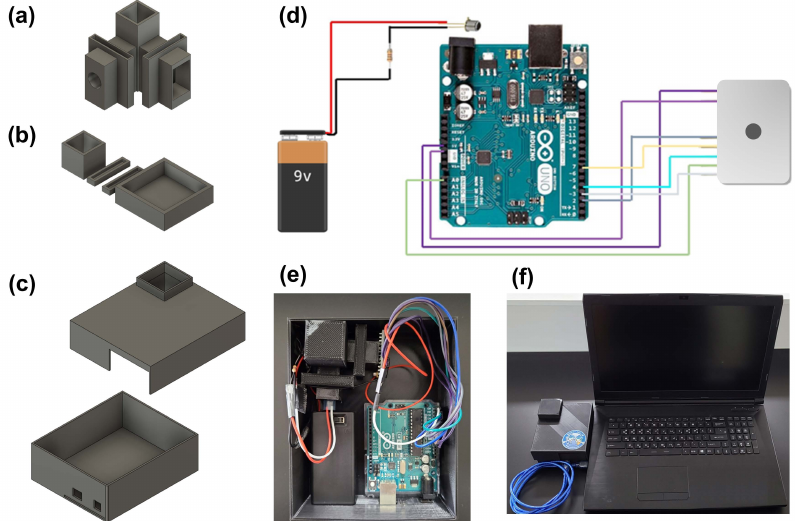
Figure 4. Schematic of various parts of the CysDDev ( a ): UV LED, sensor, and cuvette holder; ( b ) top lids for UV LED, sensor, cuvette holder; ( c ) the main case with top lid; ( d ) electronic components connected to the Arduino microcontroller; ( e ) assembly of CysDDev without the top lid; ( f ) CysDDev prototype connected to the laptop computer.